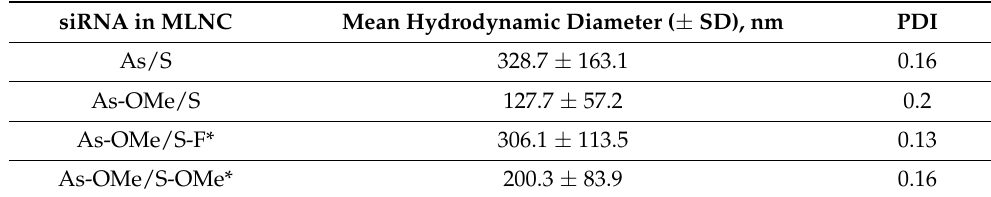
Table 4. Physicochemical parameters of MLNCs carrying different siRNAs. siRNA in